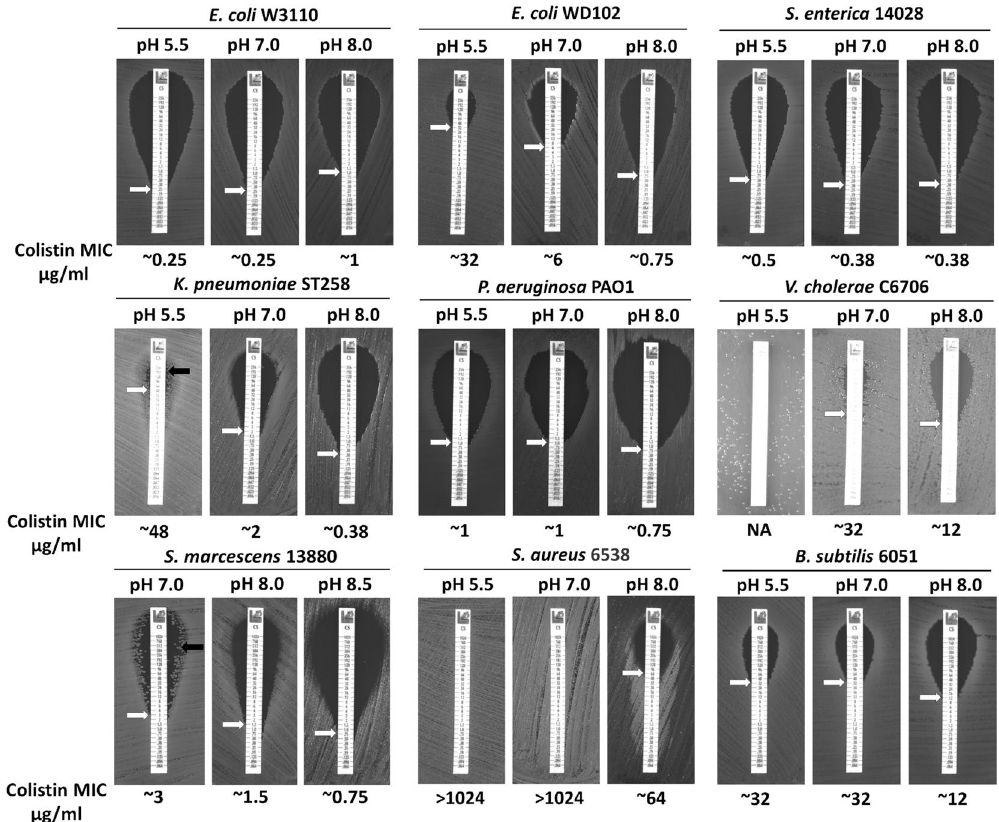
Figure 2. pH dependent colistin resistance of different bacterial species. Minimal inhibitory concentration (MIC) was determined for indicated strains on LB agar plates. The pH was adjusted with 100 mM MES for pH 5.5 and 100 mM Tris for pH 7.0, 8.0, and 8.5. Plates were analyzed after 24 h of growth at 37 °C. Approximate MICs are denoted by white arrows. Black arrows represent heteroresistant colonies of S. marcescens or K . pneumoniae